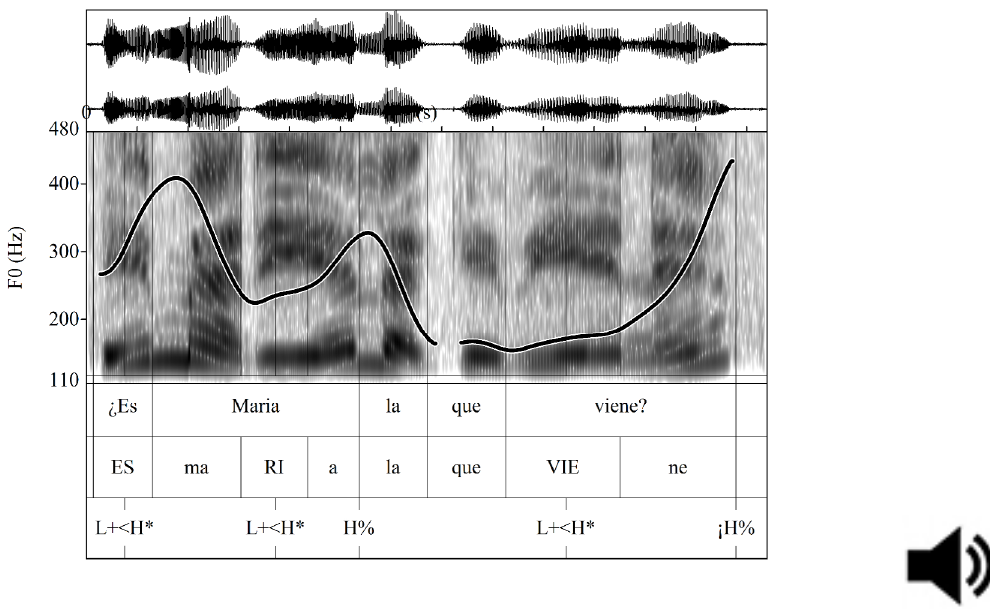
Figure 11 (Participant 9): Waveform and F0 trace for the emphatic yes-no question ¿ Es María la que viene? ‘Is María the one who’s coming?’ produced as two IPs: L+<H* (prenuclear accent ES), L+<H* H% (1 st IP nuclear configuration) and L+<H* ¡H% (2 nd IP nuclear